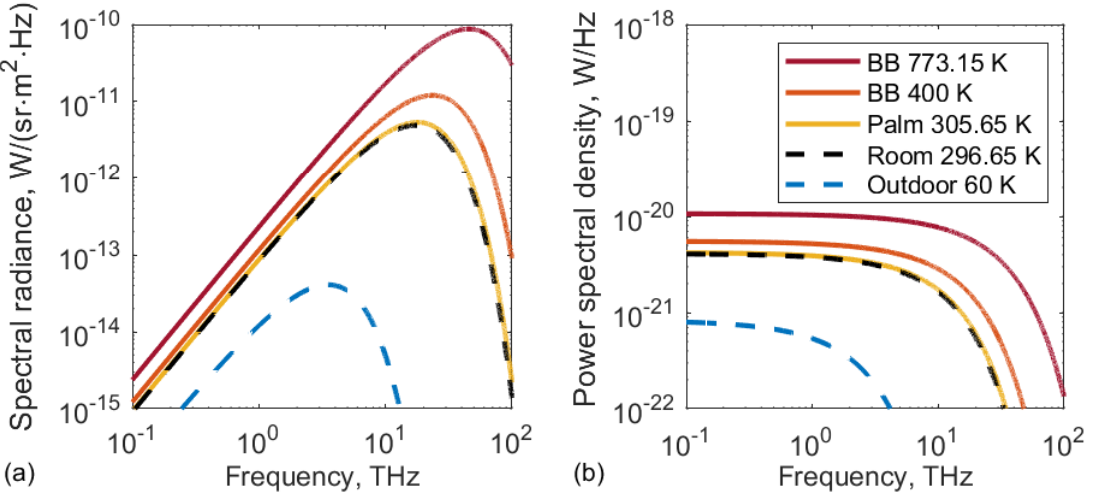
Figure 3. ( a ) spectral radiance of a black-body (BB) emitter at various temperatures; ( b ) and power spectral density received by the ideal antenna (right). Dashed lines show the usual background radiation, indoor (296.65 K, black) and outdoor (sky temperature of 60 K, blue). The solid lines display the BB radiation at the temperatures of the human palm (305.65 K, yellow), of the thermal source used in Reference [33] (773.15 K, red) and of the sensitivity limit at which thermal radiation was still detected in Reference [32] (400 K,